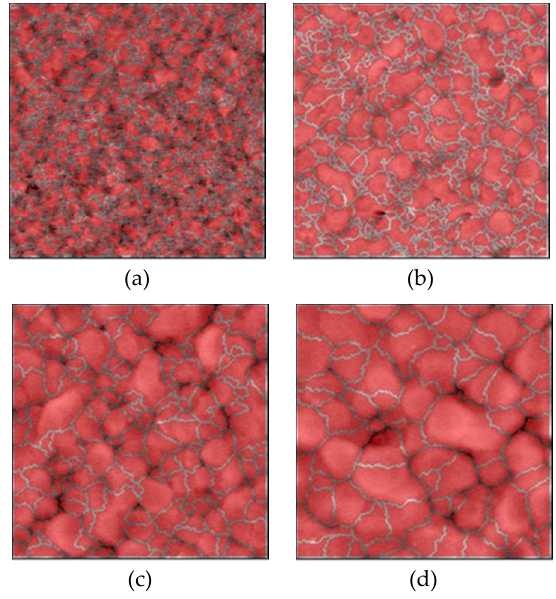
Figure 12. AFM images of Au thin films deposited on glass wafers with grains segmented using the watershed algorithm: ( a )–( d ) films with thicknesses of 15, 50, 100, 300 nm, respectively.